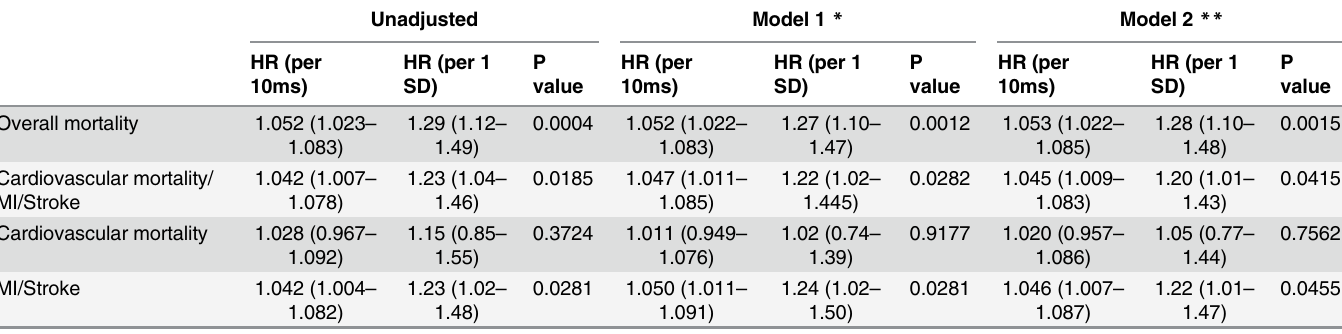
Table 3. Association of QTc B (continuous) with overall and cardiovascular